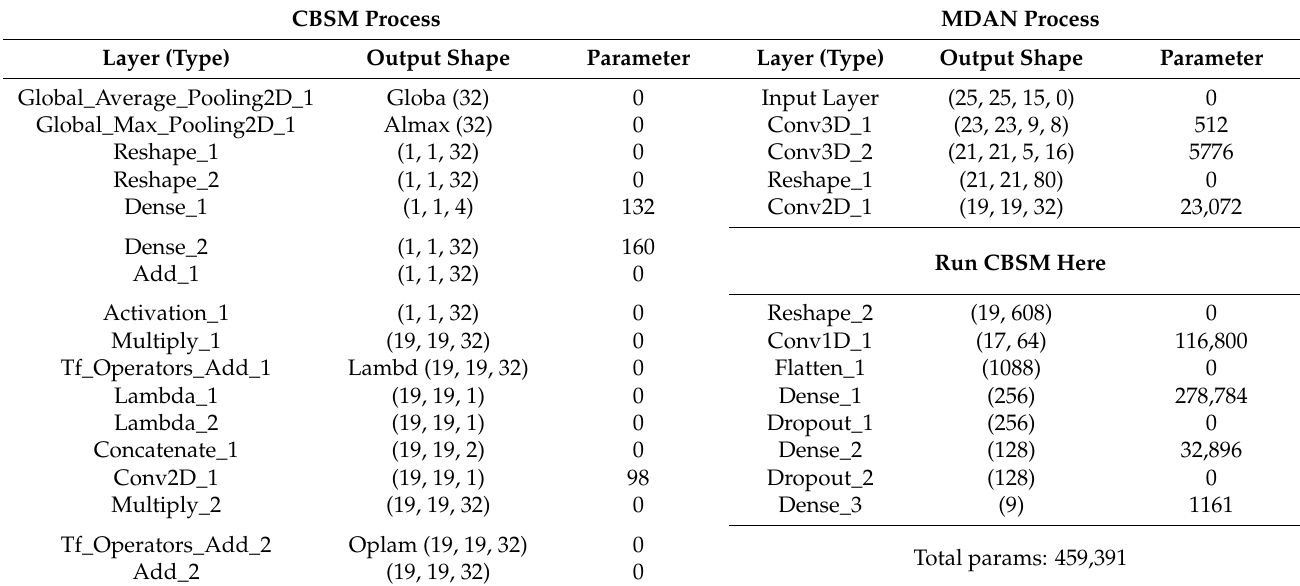
Table 4. Layer summary of the MDAN model based on the PU